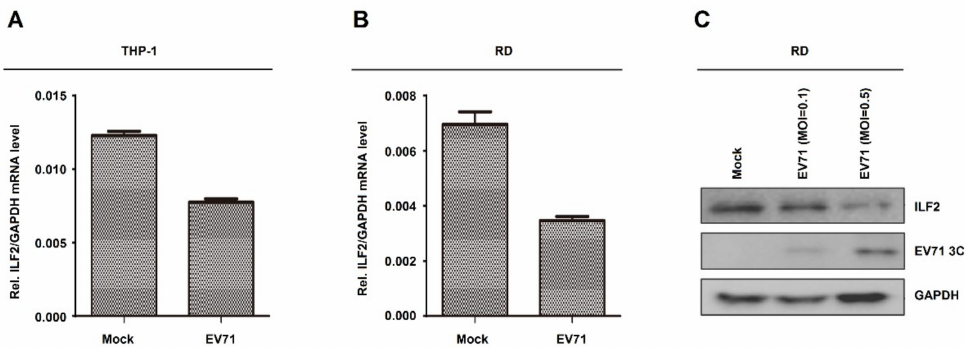
Figure 3. EV71 represses ILF2 mRNA expression and protein production. ( A ) THP-1 cells di ff erentiated into macrophages upon treatment with 12-o-tetradecanoylphorbol-13-acetate (TPA). TPA-di ff erentiated THP-1 macrophages were infected with or without EV71 (MOI = 5) for 36 h. The mRNA level of ILF2 gene was quantified by real-time PCR. ( B ) RD cells infected with or without EV71 (MOI = 1) for 12 h. The mRNA level of ILF2 gene was quantified by real-time PCR. ( C ) RD cells infected with or without EV71 (MOI = 0.1 or 0.5) for 12 h. ILF2, EV71 3C, and GAPDH proteins expressed in the cell lysates were detected by Western blot analysis. Data shown are means ±